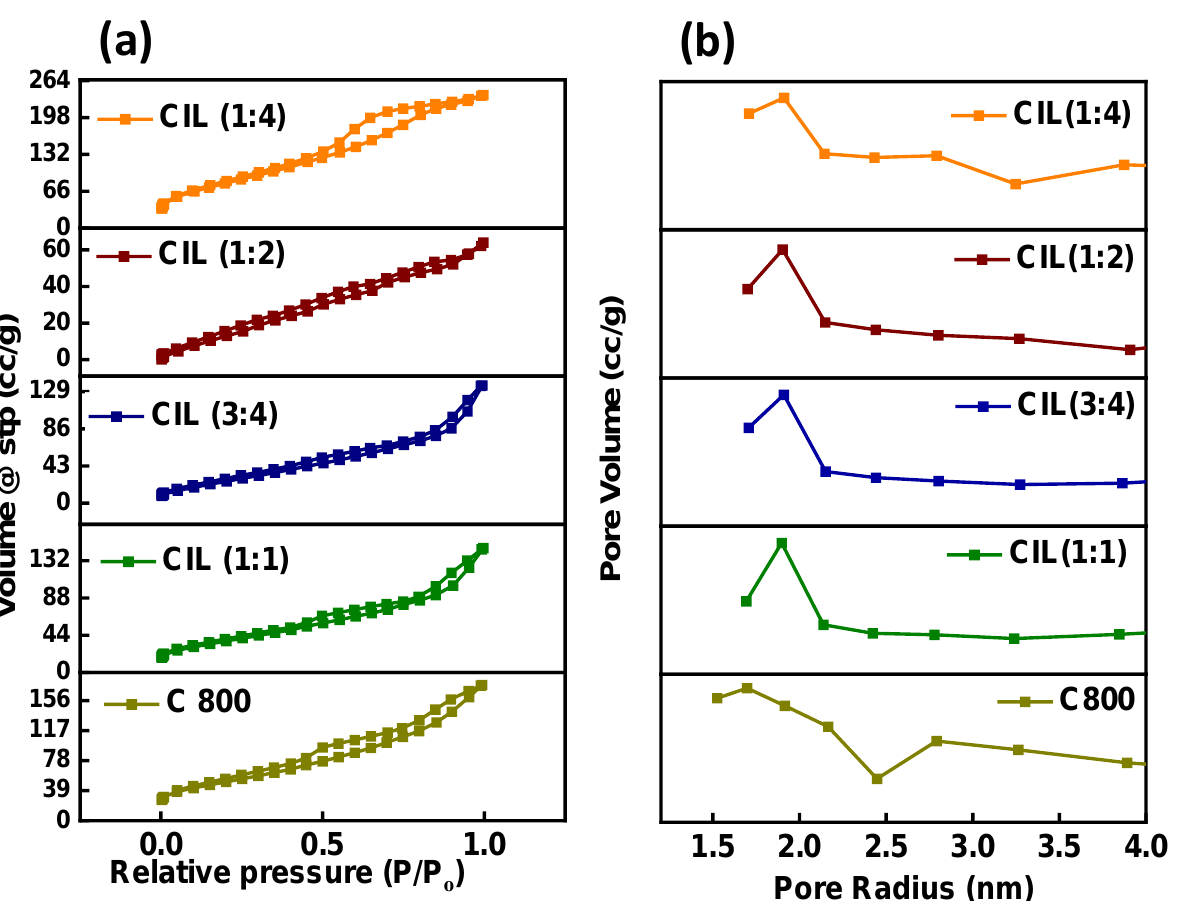
Figure 5. ( a ) Adsorption and desorption isotherms and ( b ) BJH pore size distribution curves of the synthesized materials.